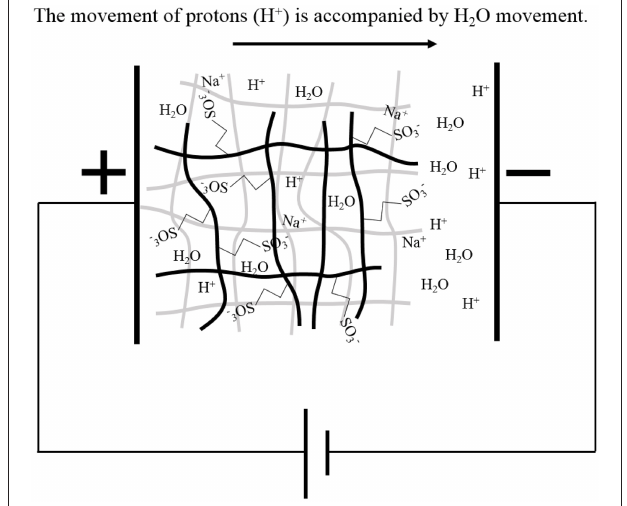
FIGURE 1 | Schematic illustration of friction change mechanism of DN gel. Protons are moved to the cathode side by adding the voltage.